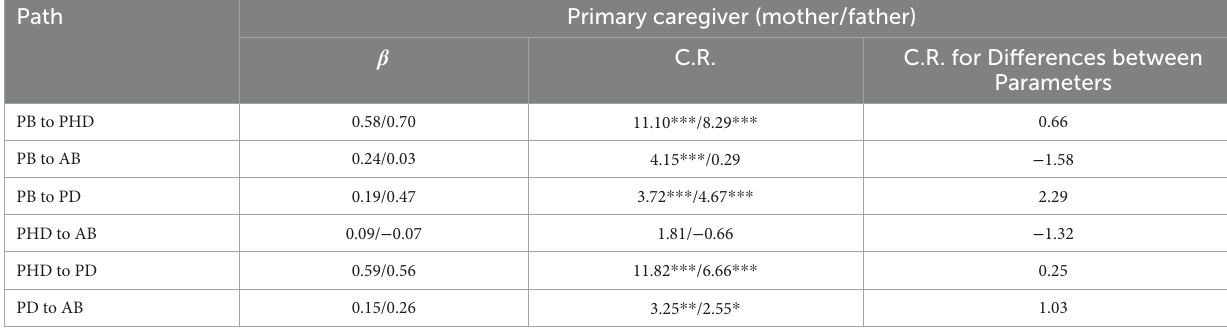
TABLE 3 Standardized path coefficients in different gender of primary